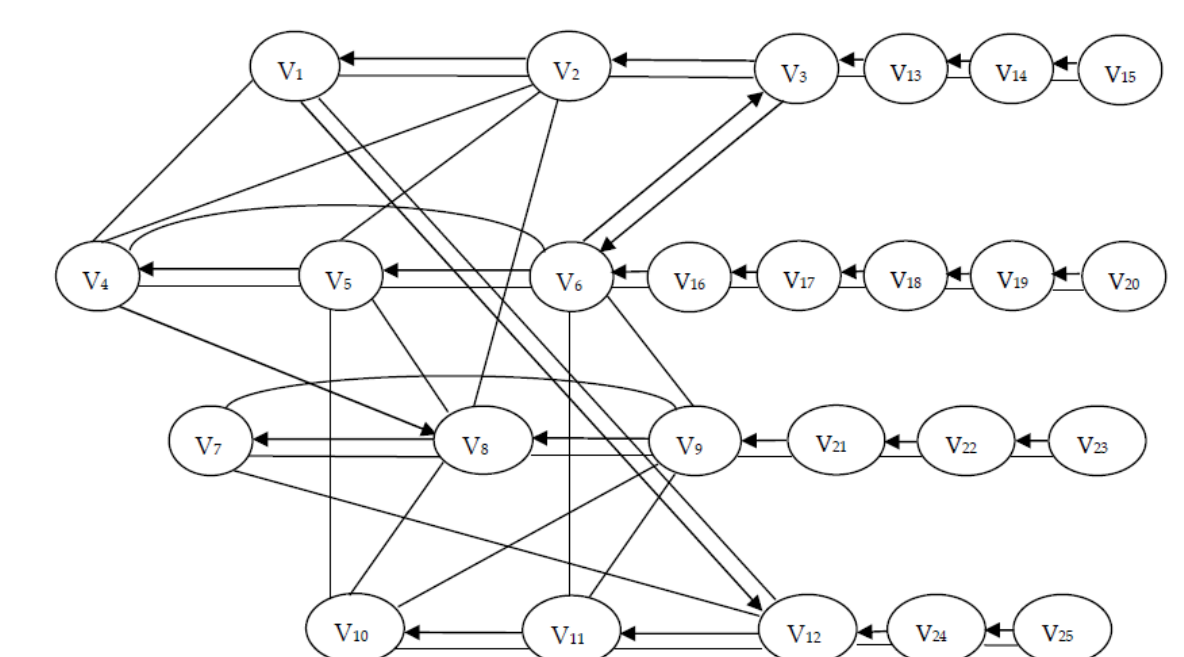
Figure 3. Mixed graph G = ( V , A , E ) determining Example 4 of the general shop scheduling problem GcMPT | t i = 1, [ r i ] | C max , optimal mixed graph coloring c ( G ) being equivalent to Example 4. The machine M 1